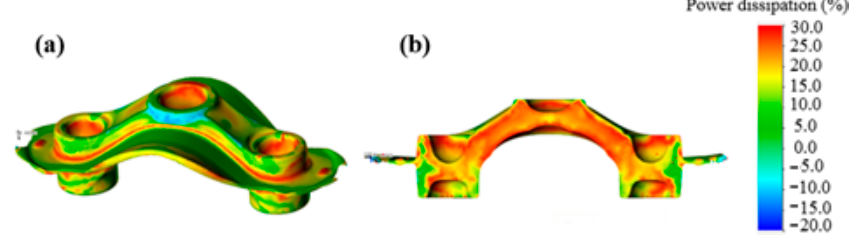
Figure 11. Processing map of AA6066-T6 workpiece. ( a ) Stereo view; ( b ) sectional